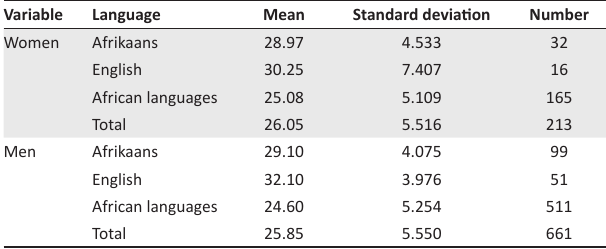
TABLE 6: Descriptive statistics for gender and language groups.